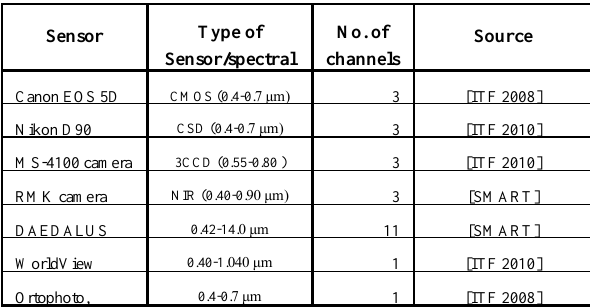
Table 1. Spectral characteristics of sensors and documents used in the